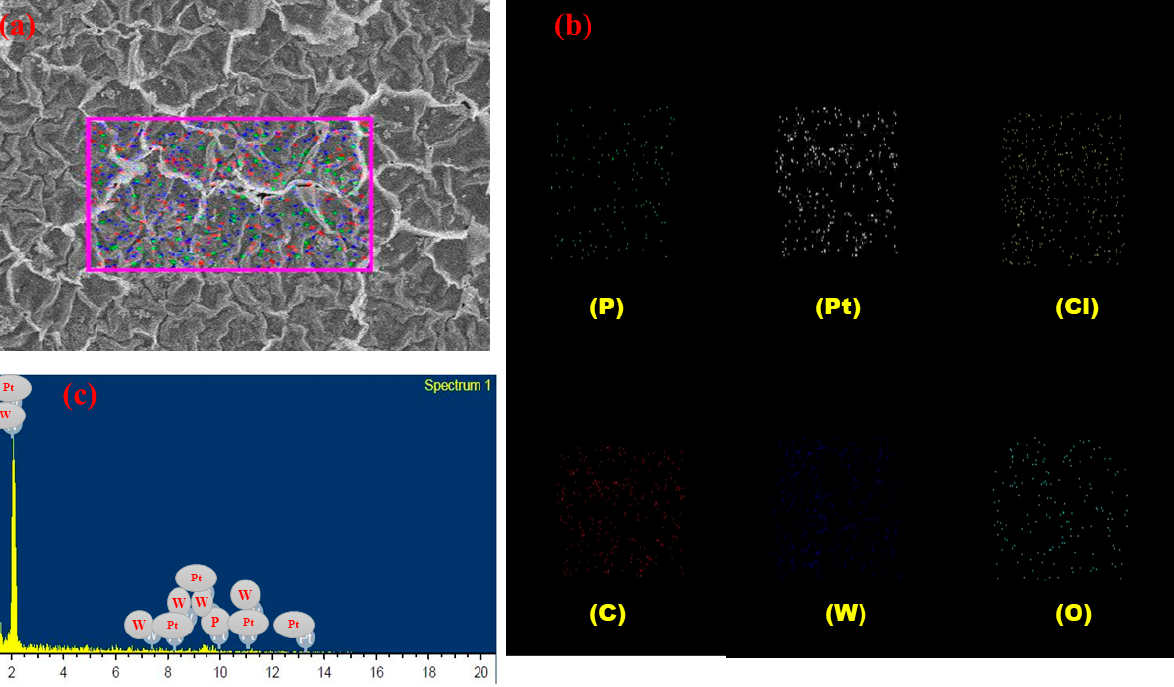
Figure 11. Represent the ( a ) surface of the IPMC membrane for EDX analysis ( b ) characteristic peaks for elements present in the membrane, and ( c ) distribution map for element in the IPMC membrane.